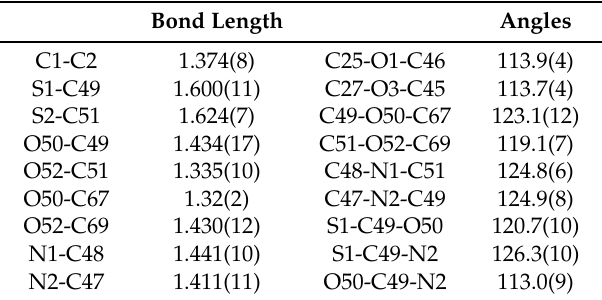
Table 1. Selected structural parameters (Å, ◦ ).